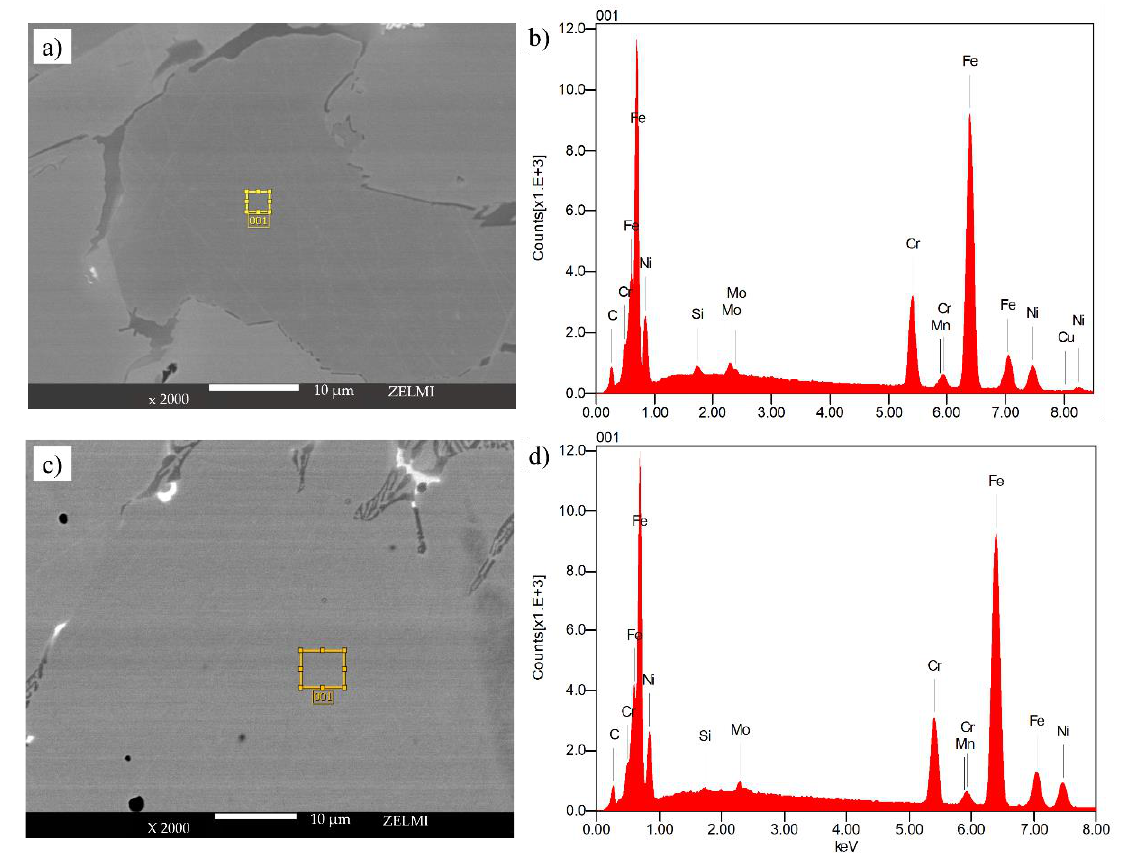
Figure 15. EDX measurement sites for samples sintered in ( a ) refractory ballast for 240 s, ( c ) vacuum for 360 s, with ( b ) the chemical composition of the refractory ballast and ( d ) vacuum-sintered samples. Table 4. Chemical composition of geometries sintered in the refractory ballast and vacuum, wt. %.